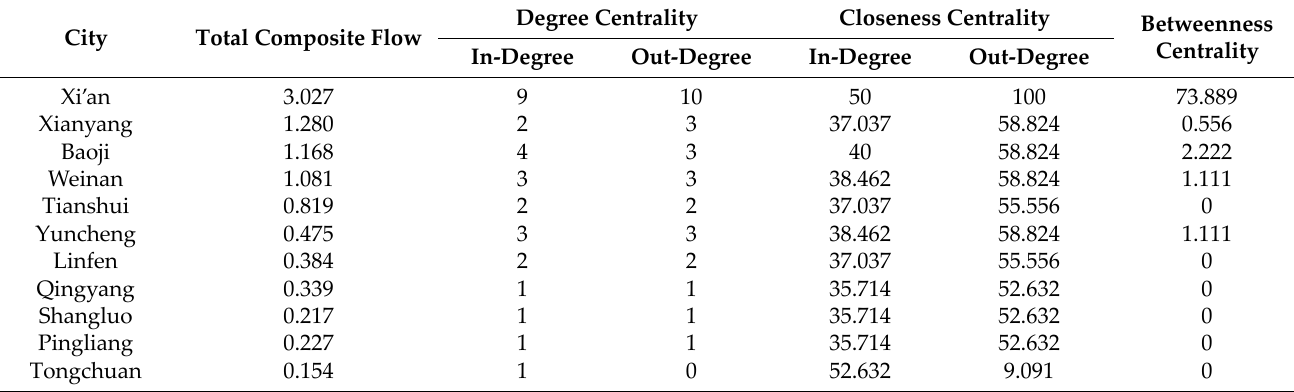
Table 4. Total composite flow and